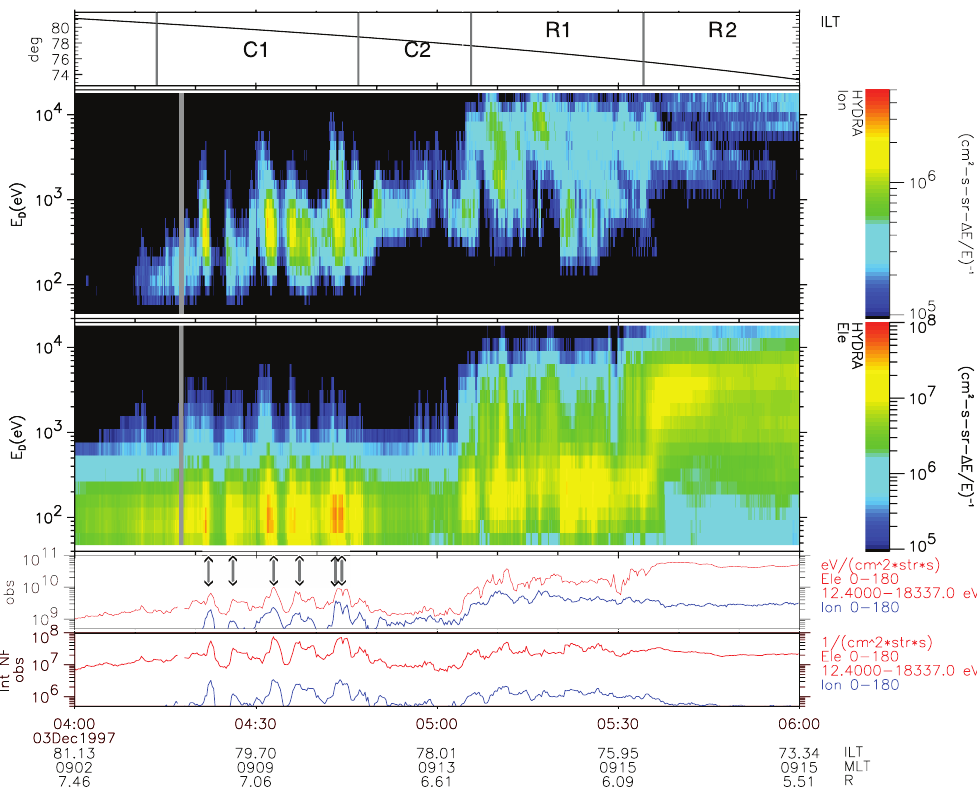
Fig. 3. Data from the Polar spacecraft pass through the region of cusp aurora. Top to bottom: invariant latitude; ion and electron energy spectrograms; integrated energy and number fluxes for electrons (red) and ions